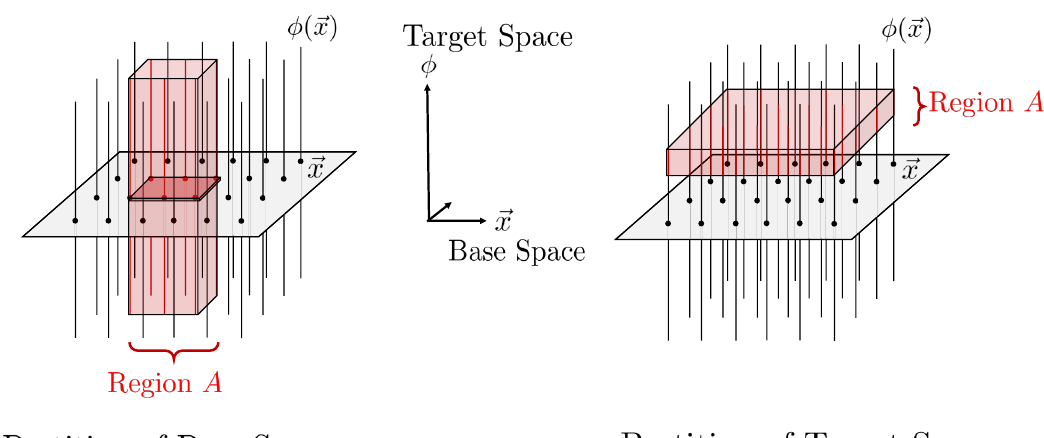
Figure 1 . Distinction between partitions of the base space (left) versus target space (right). We illustrate the case of 2+1d scalar field theory for concreteness. At every point of the base space ( ∼ = R 2 ) labeled by ~x , the local degree of freedom takes values in the target space ( ∼ = R ) with coordinate φ . Previous studies of entanglement entropy have focused on subregions of the base space where the values of ~x are restricted. Instead, we consider restrictions on the values of the field φ